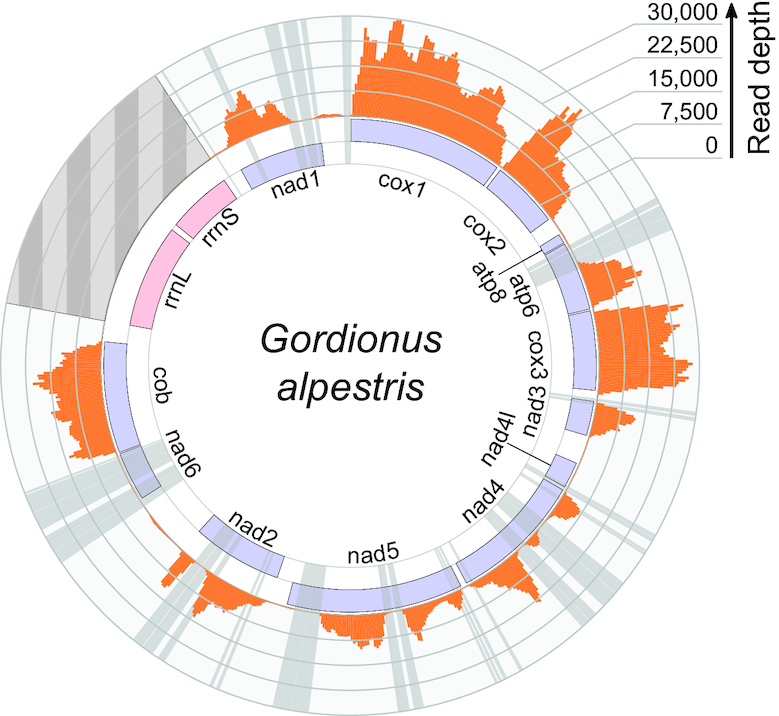
Mapping of reads from an RNA-Seq library of Gordionus alpestris. The histogram shows read depth over the mitochondrial genome of G. alpestris with the inverted repeat regions shaded gray; region containing the highly expressed rRNA genes was masked during the mapping (indicated with a striped pattern).